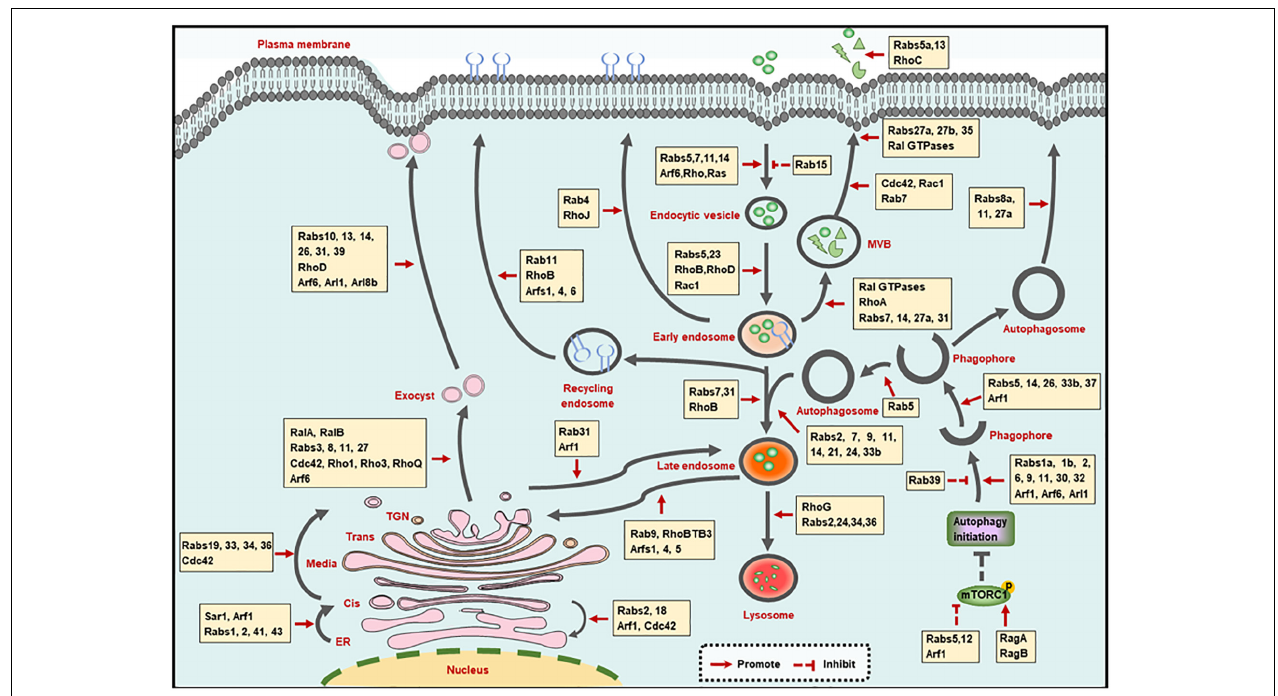
FIGURE 1 | Small GTPases in membrane trafficking pathways. The illustration shows the main intracellular membrane trafficking pathways including endocytic, exocytic, and autophagic pathways regulated by small GTPases. TGN: trans-Golgi network; ER, endoplasmic reticulum; MVB, multivesicular